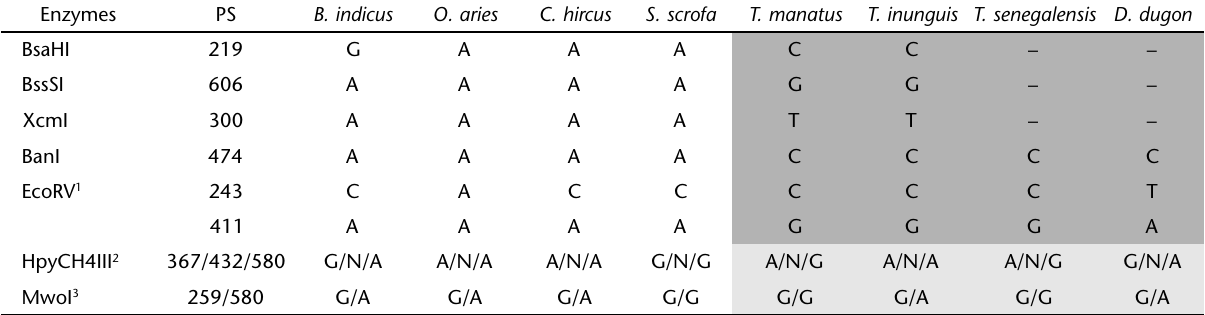
Table II. Sequence positions of SNPs and diagnostic restriction enzymes. (PS) Polymorphic site related to the cytochrome b complete sequence of T. manatus (NC_010302). Dark-gray sites are diagnostic SNPs between domestic species and manatee species. Light-gray sites are diagnostic SNPs between manatee